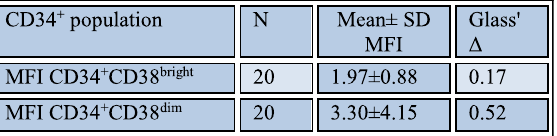
Statistical analysis. All statistical tests were performed using SPSS v26. Changes in mRNA levels of ( BCR- ABL1 & PTPRG ) over timeline were analyzed with the Wilcoxon matched pairs signed ranks test (WSRT). The effect size of TKIs was reported and assessed on both genes ( BCR-ABL1 & PTPRG ) via the Cohen’s d coefficient for which d = 0.2 was considered a ‘small’ effect size, 0.5 a ’medium’ effect size, 0.8 a ’large’ effect size and 2.0